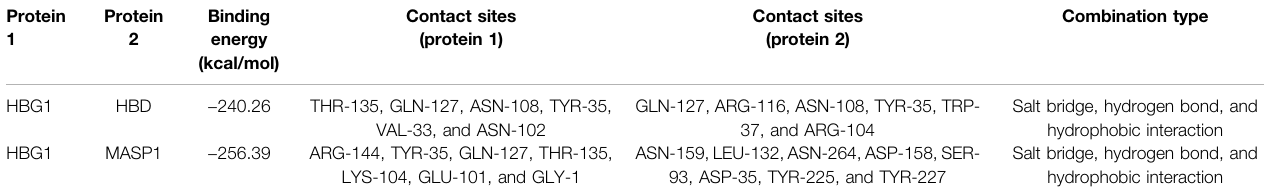
TABLE 2 | Docking results of three target proteins. Protein